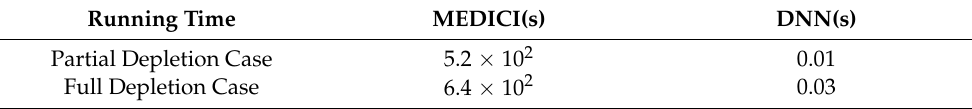
Table 3. Runtime comparison between the TCAD simulator and